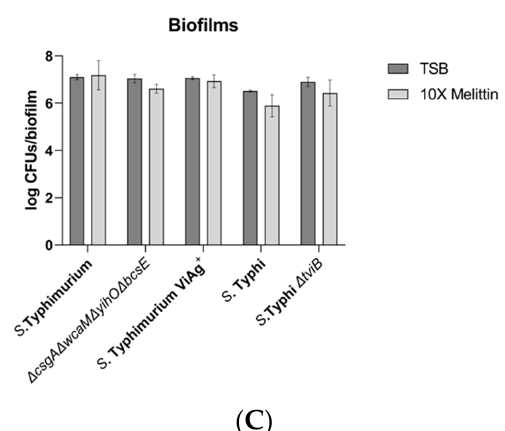
Figure 2. Sensitivity and tolerance to antimicrobial peptides (AMPs). JSG698 used for WT S . Typhi. ( A ) Growth from input of WT planktonic Salmonella after 2-hour exposure to each AMP at the minimum inhibitory concentration (MIC) determined by CFU enumeration (data are normalized to AMP-free control) ( n = 3). S . Typhimurium challenged with 0.49 µ g / mL polymyxin B and 10 µ g / mL melittin. S . Typhi challenged with 0.24 µ g / mL polymyxin B and 10 µ g / mL melittin. Significance calculated by two-way ANOVA with Dunnett’s multiple comparison test (***, p < 0.0005; ****, p < 0.0001). ( B , C ) Biofilm tolerance to AMPs supplied at 10 × the WT planktonic MIC. Significance was tested for by two-way ANOVA with a Sidak multiple comparison correction ( n = 3, daily experiments conducted in triplicate). Error bars indicate SD.